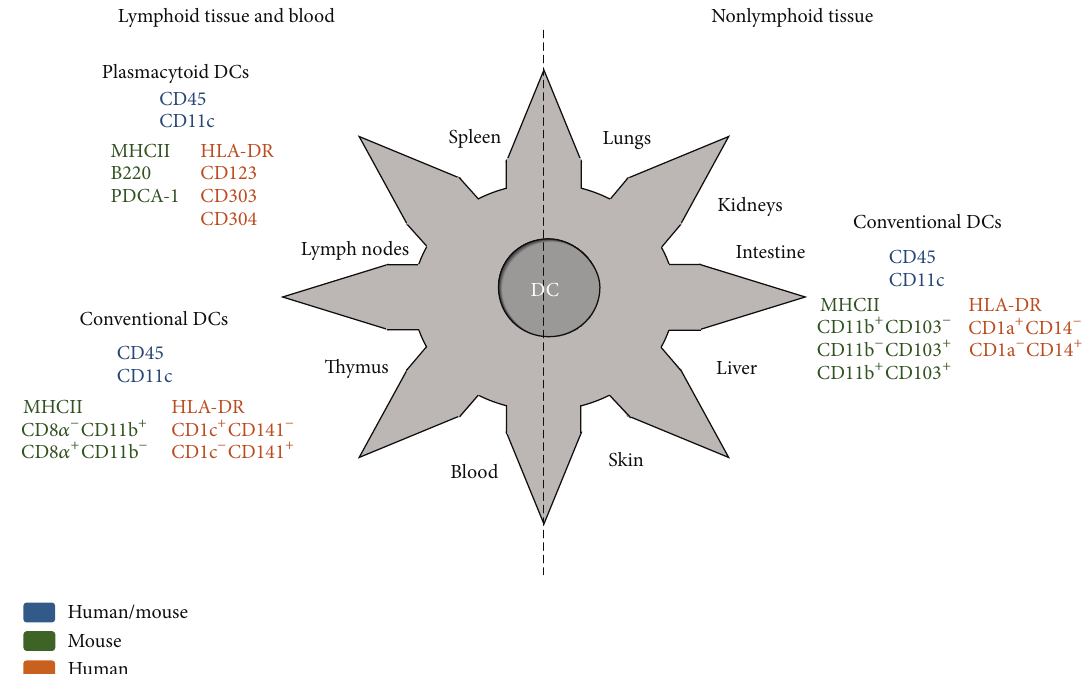
Figure 1: Most common DC surface markers used to differentiate conventional from plasmacytoid DCs and lymphoid tissue/blood from nonlymphoid tissue resident DCs. The colors indicate if a specific marker is expressed only in humans (orange), only in mice (green), or in both (blue) either in humans or in mice. Langerhans cells (LCs) are not represented. Based on [15, 125,